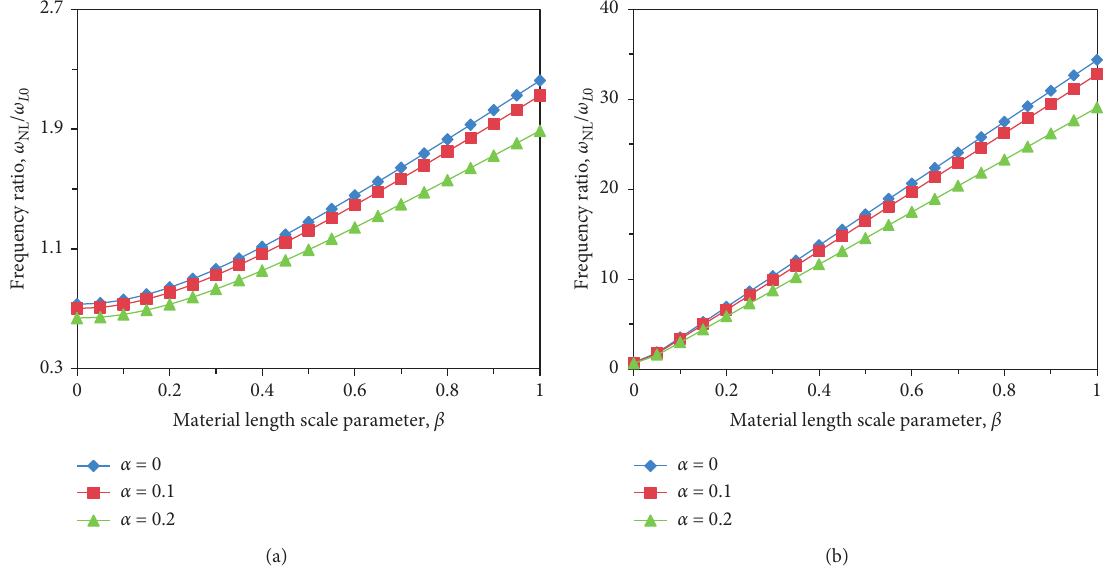
Figure 5: The variation of the frequency ratios of the FG nanobeams to the material length scale parameter for k � 5, L / h � 15, and � 0 . 01: (a) without thickness effect; (b) with thickness effect. V 0